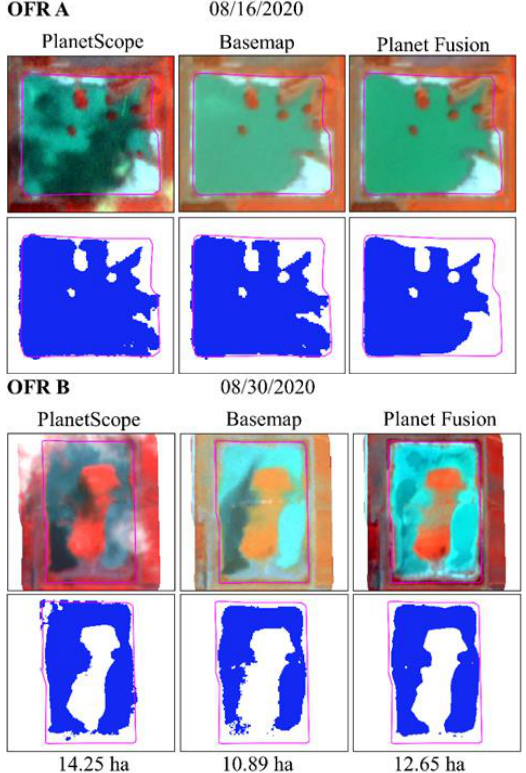
Figure 9. OFRs A and B (see Table 2) PlanetScope, Basemap, and Planet Fusion false-color composites (blue: red, green: green, and red: NIR) and the surface-water classification for 16 August 2020 (OFR A) and 30 August 2020 (OFR B).